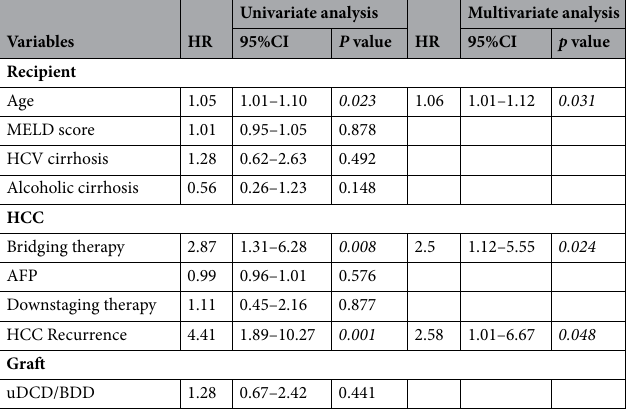
Table 4. Univariate and multivariate analysis for predictors of patient survival. Italic values indicate statistically significant. AFP alpha-fetoprotein; CI confidence interval; DBD donation after brain death; HCC hepatocellular carcinoma; HCV hepatitis C virus; HR hazard ratio; MELD model for end-stage liver disease; OLT orthotopic liver transplantation; uDCD uncontrolled donation after circulatory death.